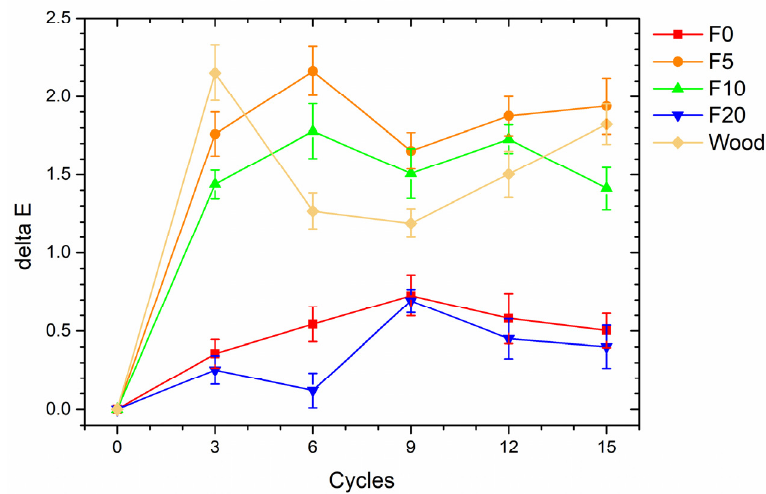
Figure 6. Color variation of the samples during climatic chamber exposure.